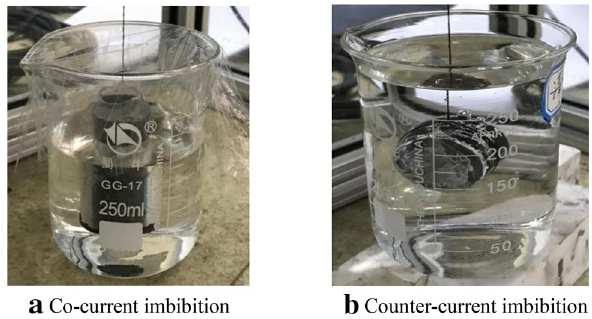
Fig. 2 Different imbibition direction of rock samples. For co-current imbibition, epoxy was used to wrap the side of the sample so only the lower end face made contact with water, and the beaker was sealed to prevent evaporation. For countercurrent imbibition, epoxy was used to seal the side of the core and one end face, leaving only one end face in contact with experimental